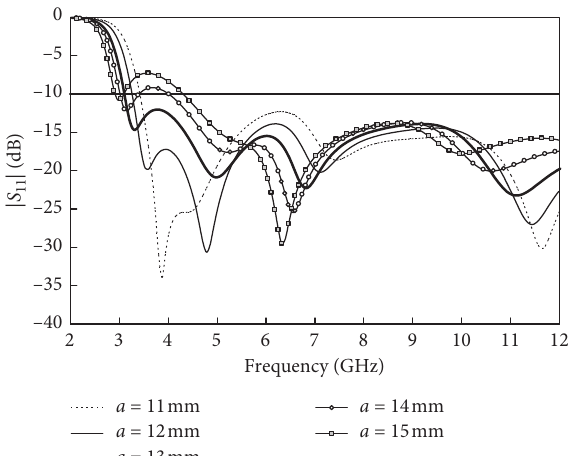
Figure 6: Simulated | S 11 | under varying d of 1, 3, and 5mm.